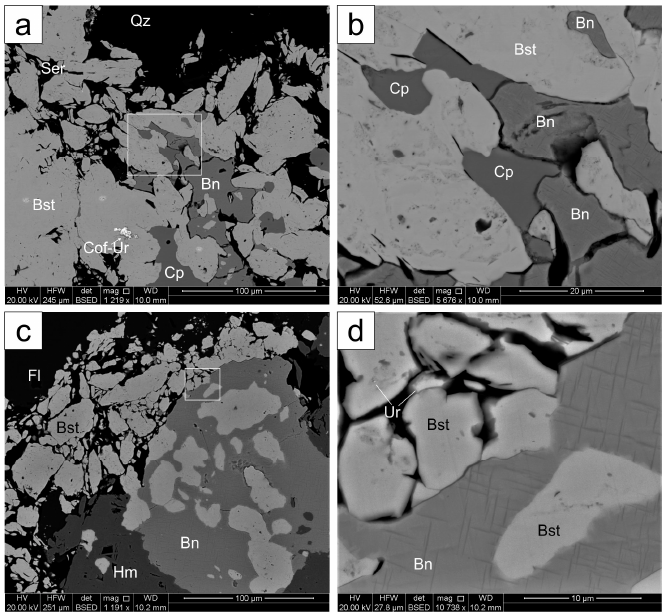
Figure 4. BSE images showing textural aspects of sulfide-associated bastnäsite: ( a ) Bastnäsite (Bst) with interstitial chalcopyrite (Cp) and bornite (Bn). Note scalloped boundaries between sulfides and bastnäsite (sample RX6720). Cof-Ur: uraninite with rim of coffinite, Qz-quartz, Ser-sericite; ( b ) Detail of domain shown by white box on (a). Discolorations in bastnäsite are fine inclusions of hematite and sericite; ( c ) Patchy, subhedral bastnäsite in matrix and within bornite (Sample RX6721). Fl-fluorite, Hm-hematite; ( d ) Detail of domain shown by white box on (c). Bornite displays lamellar exsolution of chalcopyrite. Uraninite is included in, and interstitial to bastnäsite.